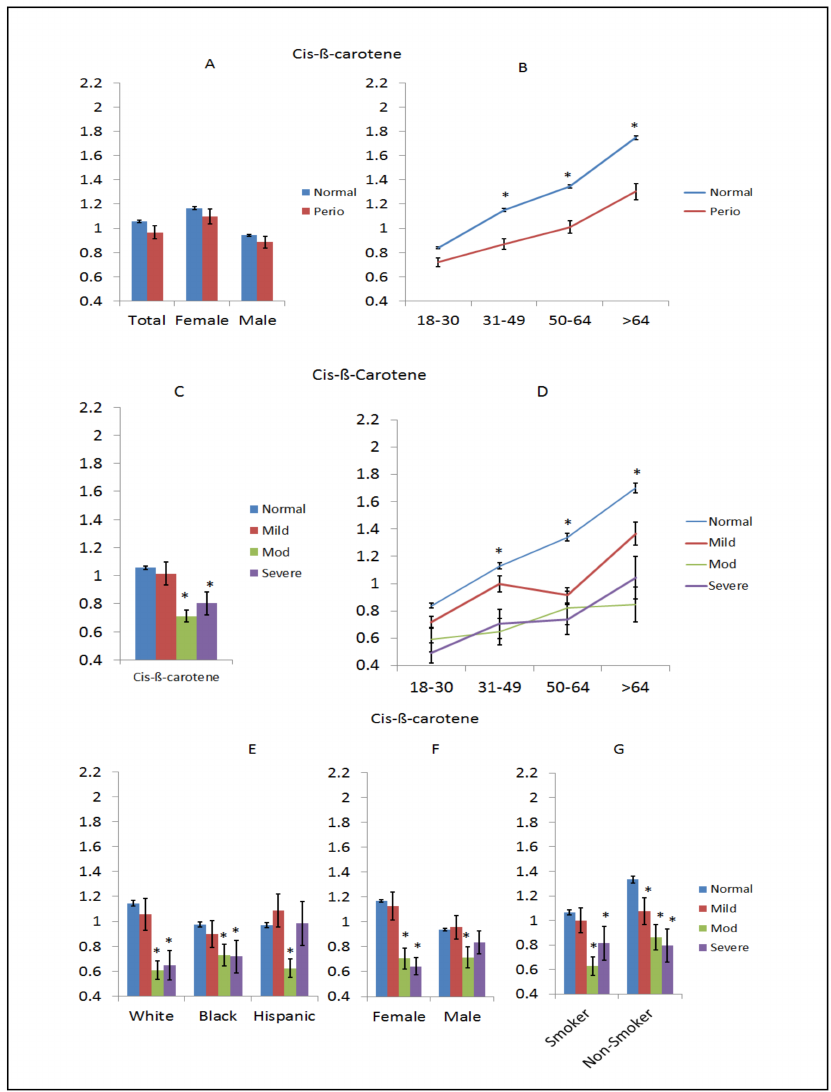
Figure 1. Levels of cis- β -carotene ( µ g/dL) in subjects with or without periodontitis stratified upon sex ( A ), age ( B ), disease severity ( C ), disease severity and age ( D ), race/ethnicity ( E ), disease severity and sex ( F ), and disease severity in smokers ( G ). The bars denote group means and the vertical brackets enclose 1 standared error of the mena (SEM). The asterisk (*) denotes significantly different than the normal group at p <